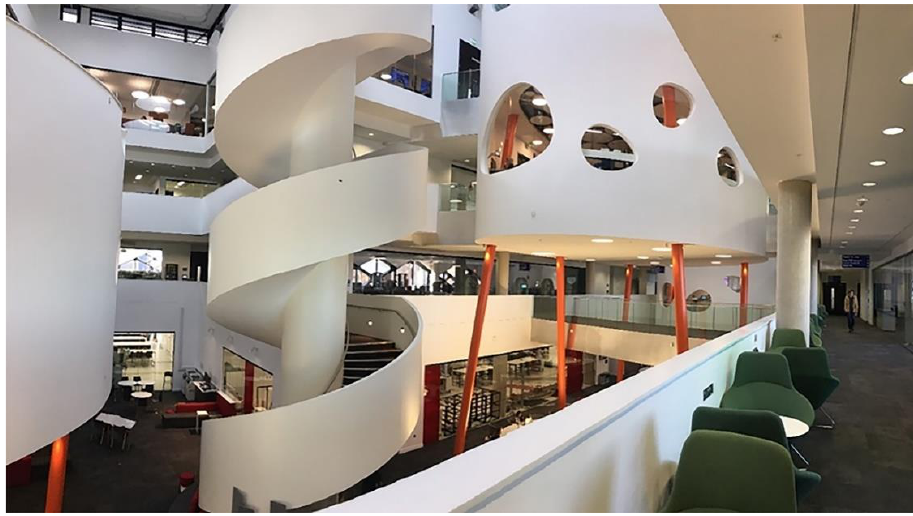
Figure 2. Atrium Space of the Diamond at University of Sheffield.